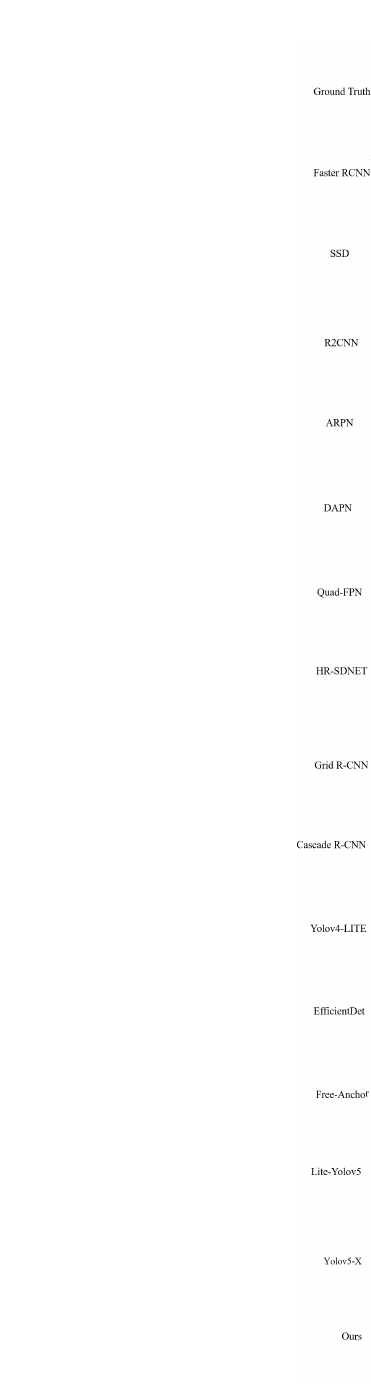
FIGURE 11 The visual detection outcomes of CNN-based approaches for offshore and inshore ships based on SSDD Dataset. Results from (A) is ground truth, results from (B) is Faster-R-CNN method, results from (C) SSD method, results from (D) is R2CNN method, results from (E) is ARPN, results from (F) is DAPN, results from (G) is Quad-FPN, results from (H) is HR-SDNet, results from (I) is Grid R-CNN, results from (J) is Cascade R-CNN, results from (K) is YOLOv4-LITE, results from (L) is Ef fi cientDet, results from (M) is Free-Anchor, results from (N) is Lite-Yolov5, results from (O) is yolov5-X, and results from (P) is our proposed method. Note the pink circle show the false detection of ship and red circle is show the missing